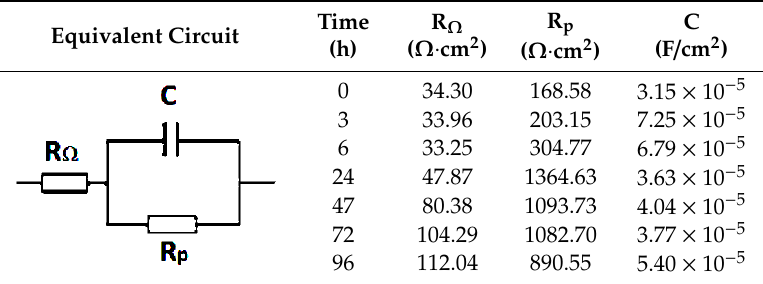
Figure 11. Electrochemical Impedance Spectroscopy of EZ51-IM350 immersed in PBS: ( a ) Nyquist diagram, ( b ) bode diagram of the module, ( c ) bode diagram of the angle, and ( d ) comparison of calculated i corr from Figure 10b and from Nyquist adjustment in Table 3 with B = 45 mV. Table 3. Equivalent circuit of Randles used for fitting the experimental EIS curves of the EZ51-IM350 alloy. The table lists the values of R Ω , R p and C (capacitance).